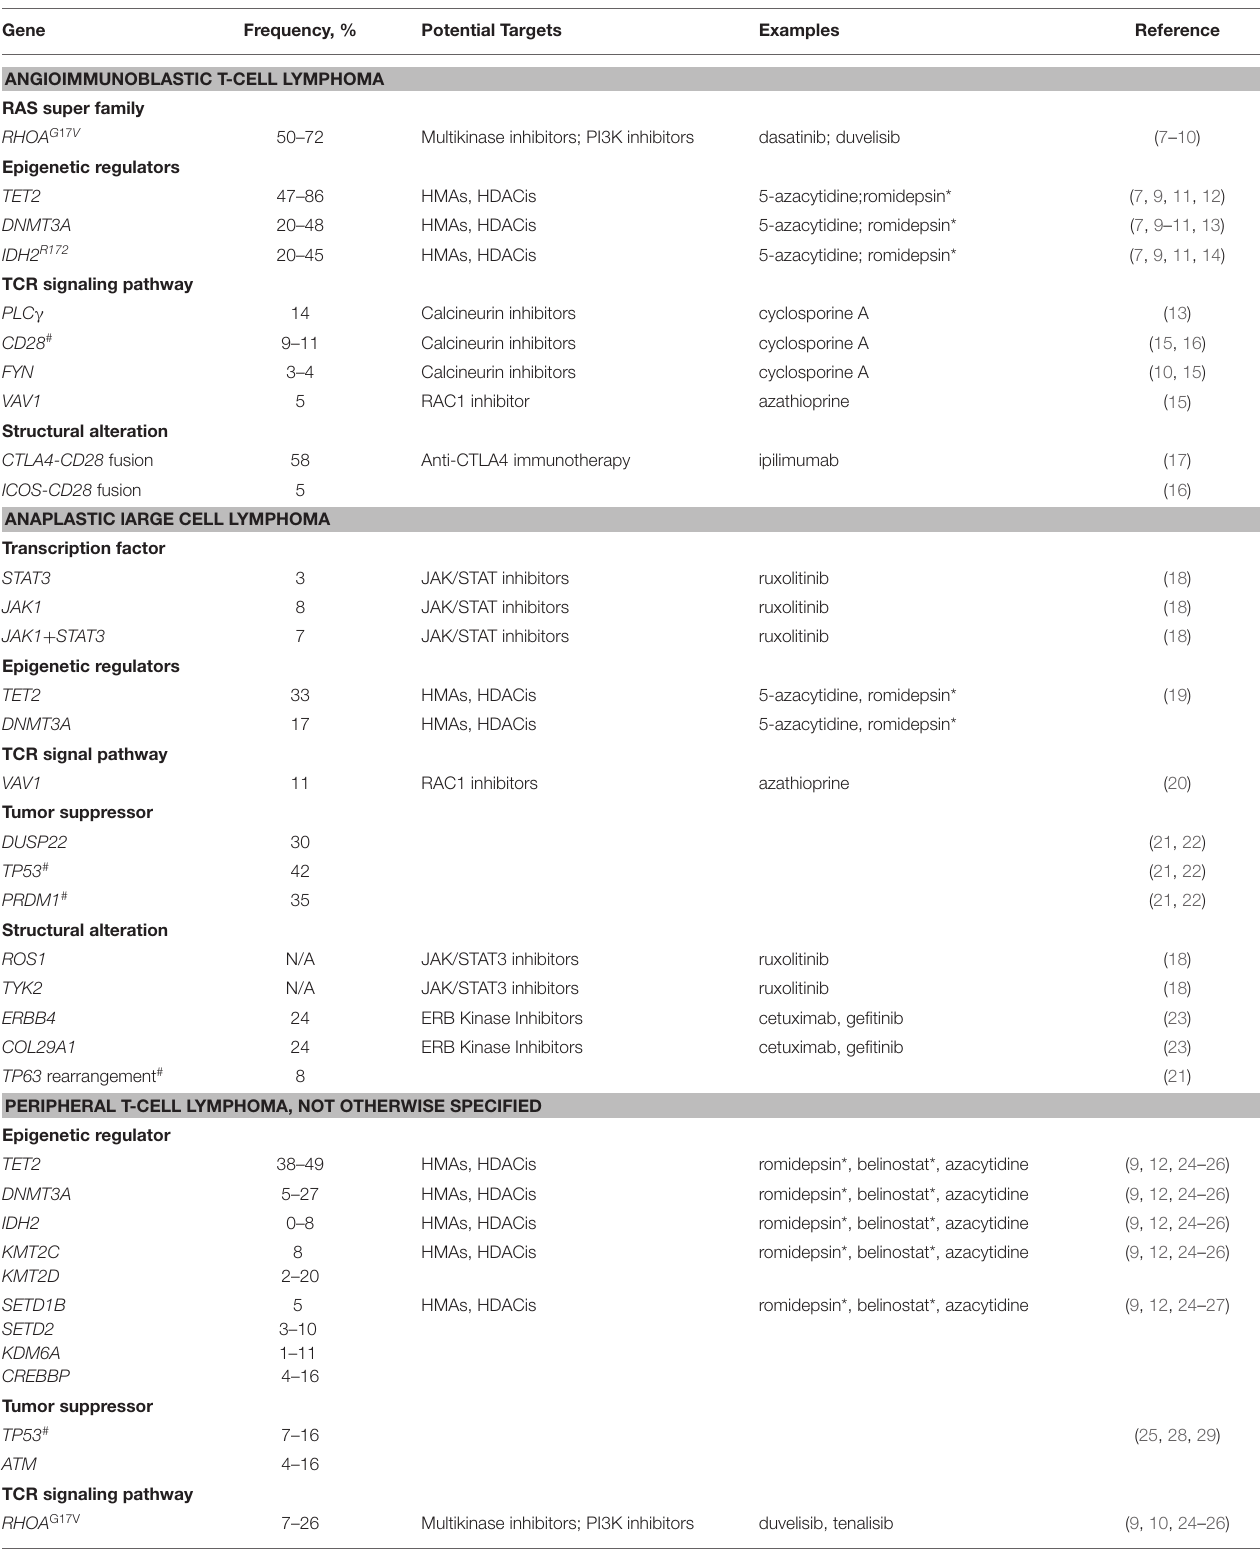
TABLE 1 | Genetic aberrations reported in the 3 most common types of PTCL.